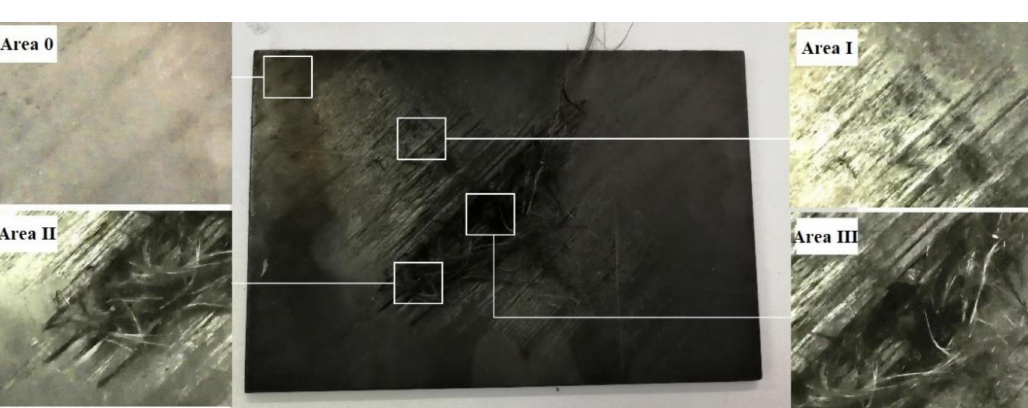
Figure 6. Di ff erent temperature areas of 45 ◦ unidirectional